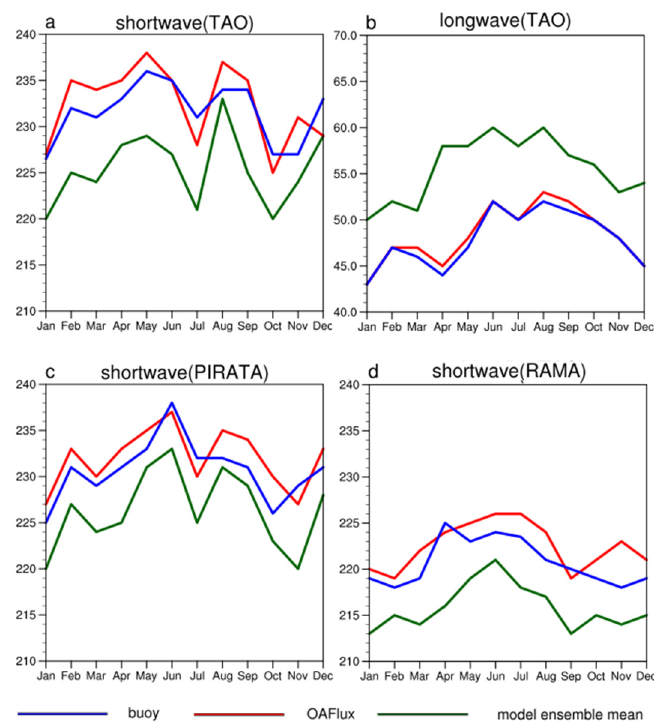
Figure 7. The annual cycle of ( a ) Q SW and ( b ) Q LW at the TAO buoys in the Pacific, ( c ) Q SW at the PIRATA buoys in the Atlantic, and ( d ) Q SW at the RAMA buoys in the Indian Ocean using data from 1997 to 2008. Q LW at the RAMA and PIRATA locations were not plotted because of insufficient data from the buoys during this period. (unit: W m − 2 ).